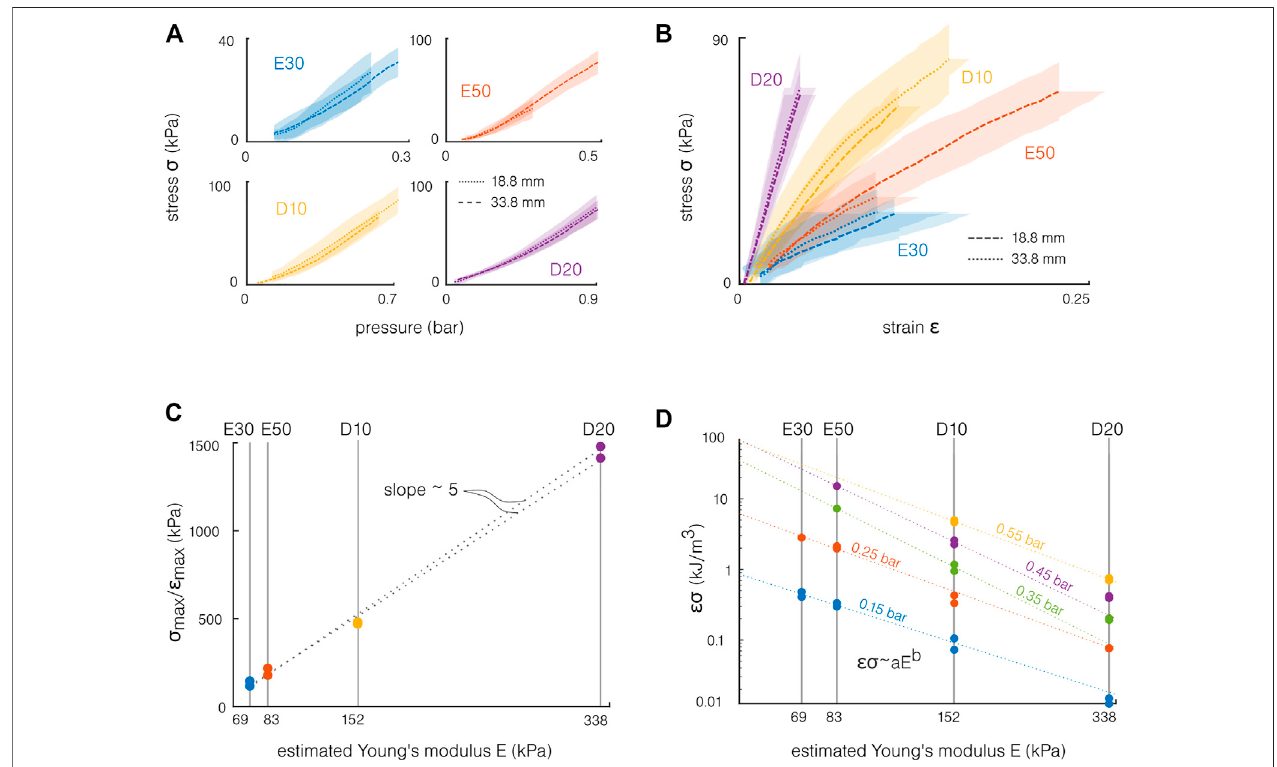
FIGURE 6 | In fl uence of the material for the molded actuators. (A) The actuation stresses computed from the blocking force superpose for the two tested lengths. (B) The actuation stress and strain are synchronized using the pressure. A stiffer material increases the slope of this curve, “ stiffening ” the actuation. (C) The actuation stiffness σ max / ϵ max is proportional to the material stiffness. (D) An estimated energy density σ ϵ is presented in a log – log diagram for different pressures. This product increases with the pressure and decreases with the material stiffness. The experimental values can be fi tted by the equation σ ϵ (cid:1) aE b , with a and b fi tting